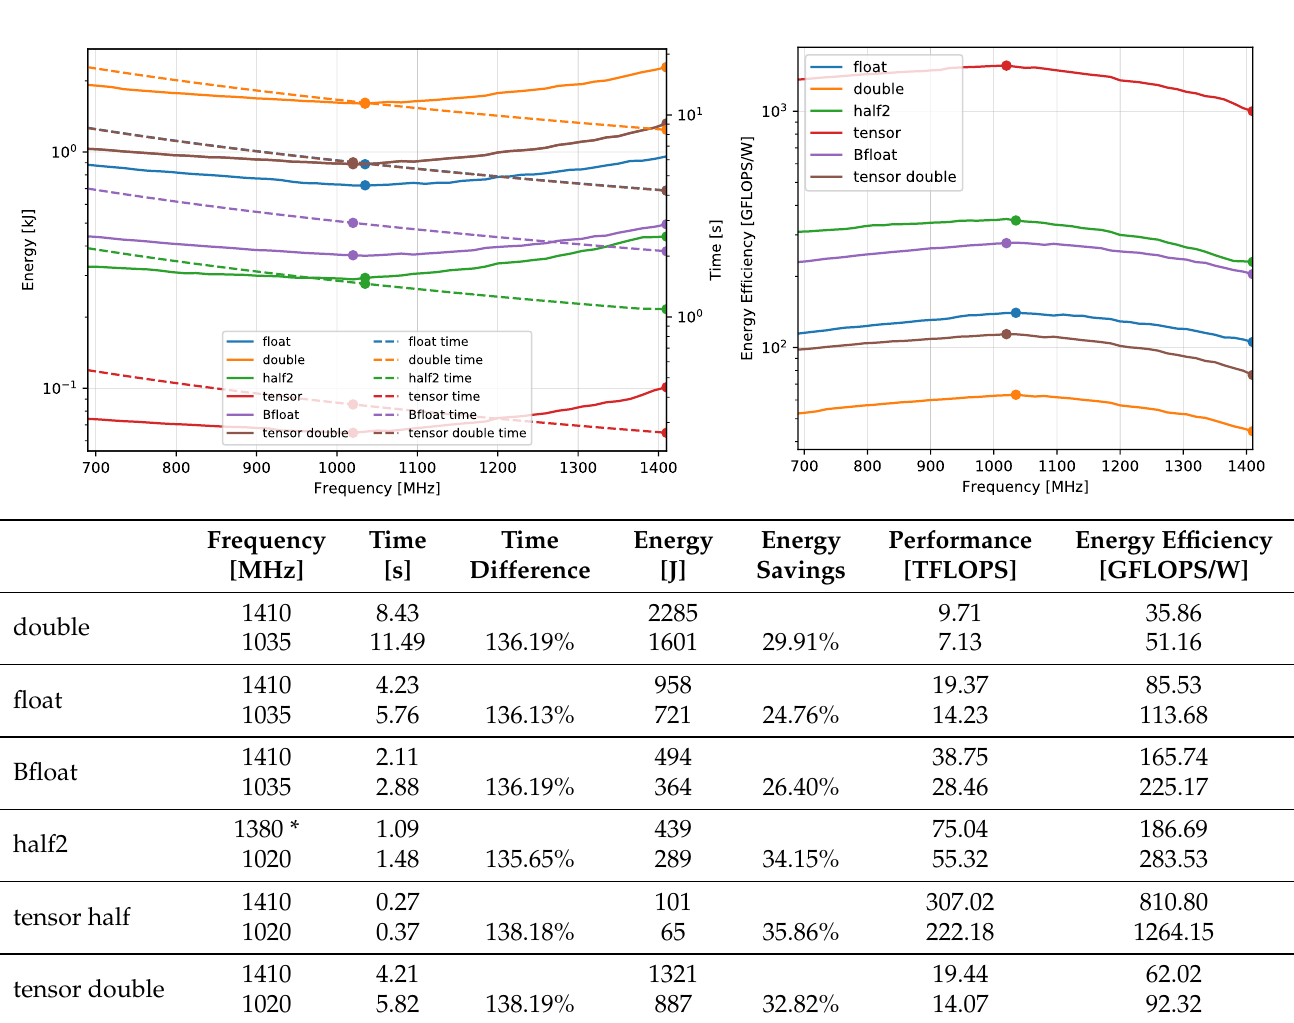
Figure 9. DGX-A100 frequency scaling of Mandelbrot benchmark. The plot in the top left corner shows consumed energy and run-time of workload. The plot in the top right corner shows energy efficiency. The plots are in logarithmic scale. The table at the bottom of the figure shows the time difference, energy savings, and energy efficiency of the Mandelbrot benchmark at the base and at the optimal frequency. The marker in the plot highlights the two frequencies from the table. * During half2 test the maximum frequency 1410 MHz was not reached due to power